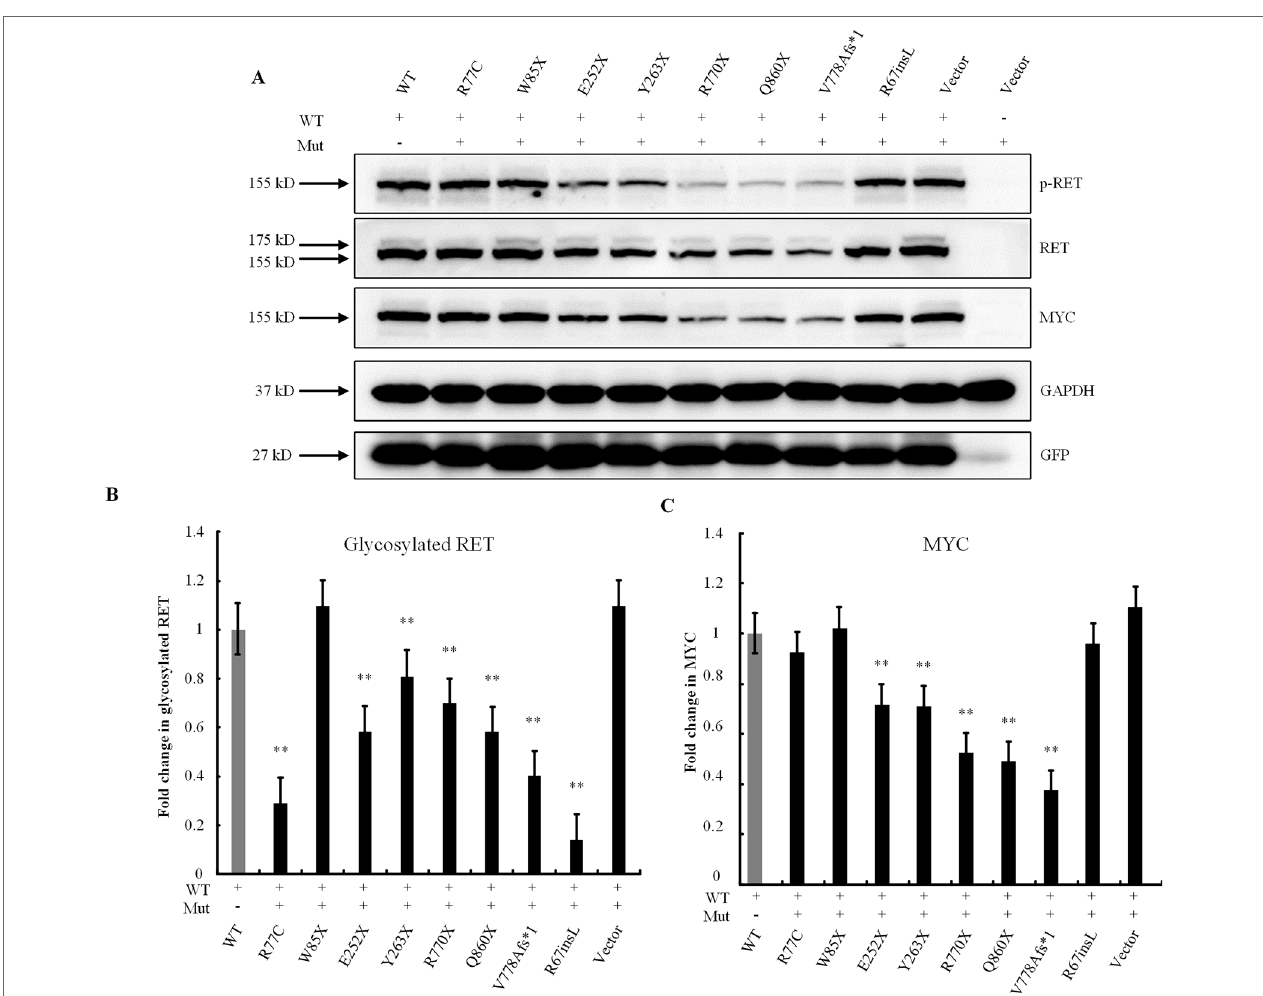
FIGURe 4 | Dose-dependent effects of RET mutations. (a) Western blot analysis of the lysates of HEK293T cells transfected with RET-WT or cotransfected with RET-WT and a RET-mutant construct, namely, p.R77C, p.W85X, p.E252X, p.Y263X, p.R770X, p.Q860X, p.V778Afs*1, p.R67insL, or empty vector (EV). (B) Densitometric analysis of glycosylated RET protein. Values were normalized using GFP and GAPDH. (C) Densitometric analysis of MYC. Values were normalized using GFP and GAPDH (** P <